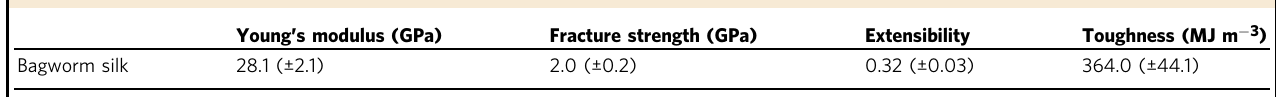
Table 3 Tensile properties of E . variegata bagworm silk